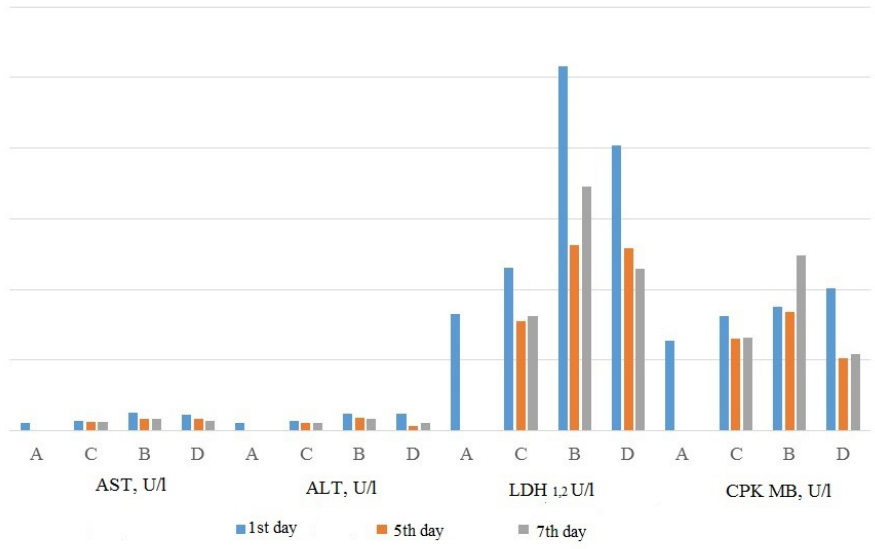
Figure 3. Activity of transaminases in the blood according to the results of the biochemical study.